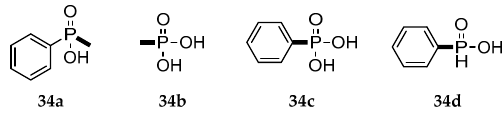
Figure 13. Flame retardant 34a – 34d structures.